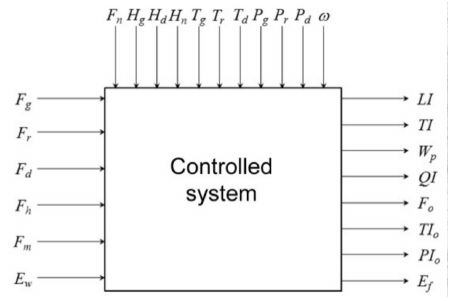
Figure 6. General structure of the